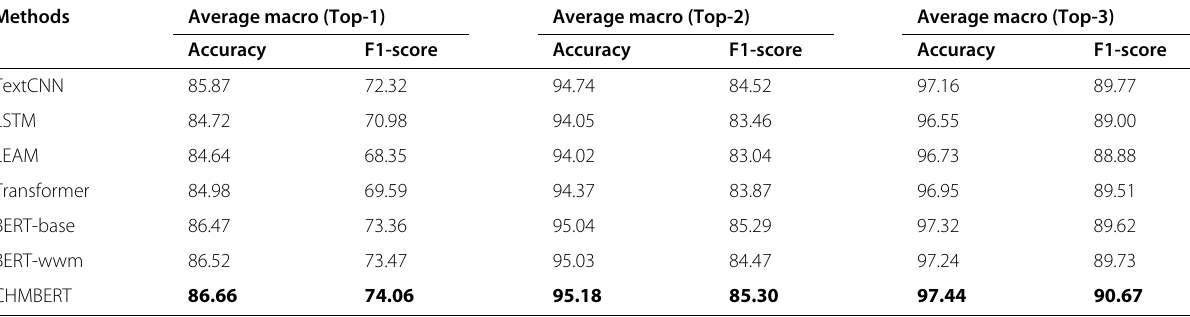
Table 2 Average macro accuracy and F1-score for disease prediction